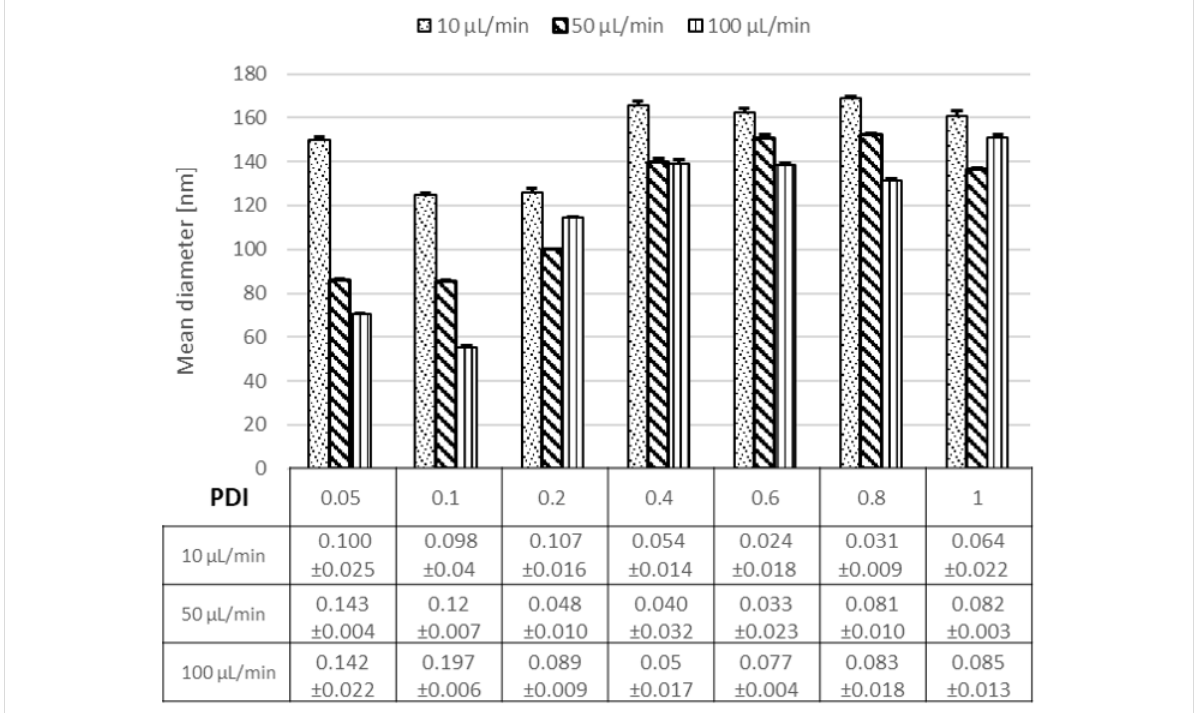
Figure 1: The effect of the flow rate ratio (0.05–1.0) and flow speed of the aqueous phase (10–100 µL/min) on NP size and size distribution.